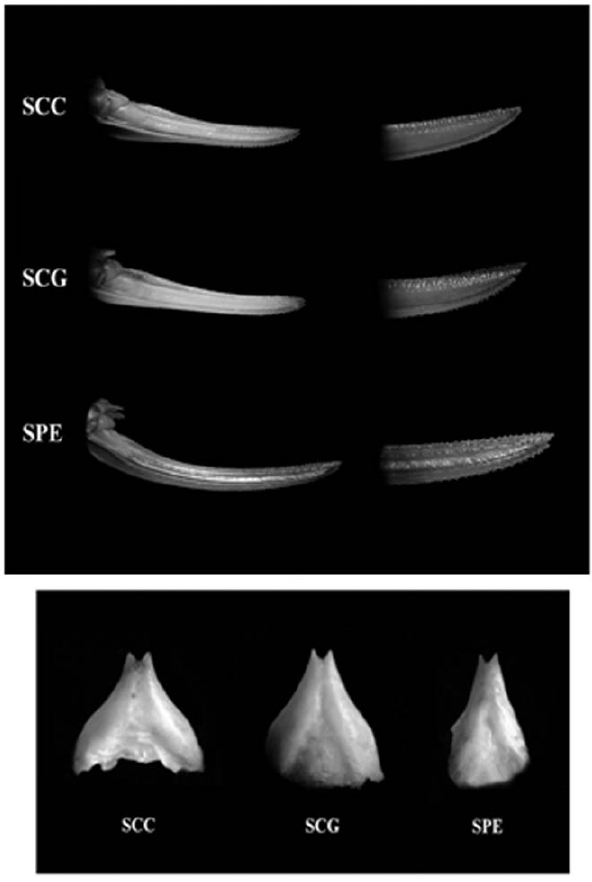
Figure 6. The shape of the ovipositor and subgenital plate is clearly different between Sagapedo and S.c.campbelli , but not between the two subspecies of the latter. Abbreviations: SCC - S. c. campbelli; SCG - Saga c. gracilis and SPE – S. pedo